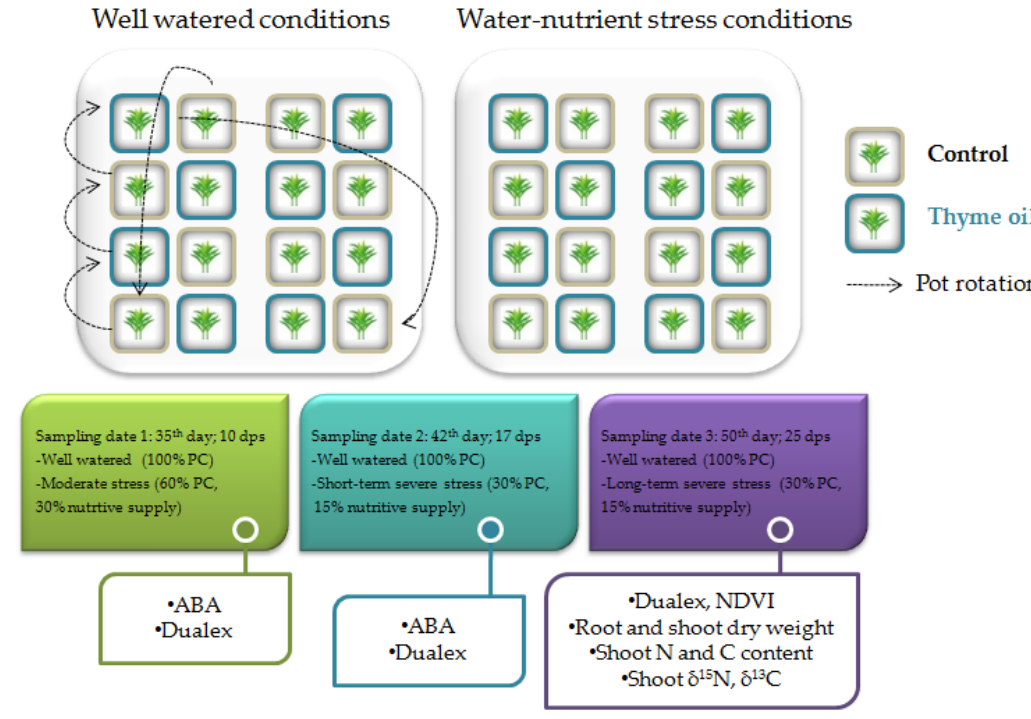
Scheme 1. Schematic illustration of the experimental design.